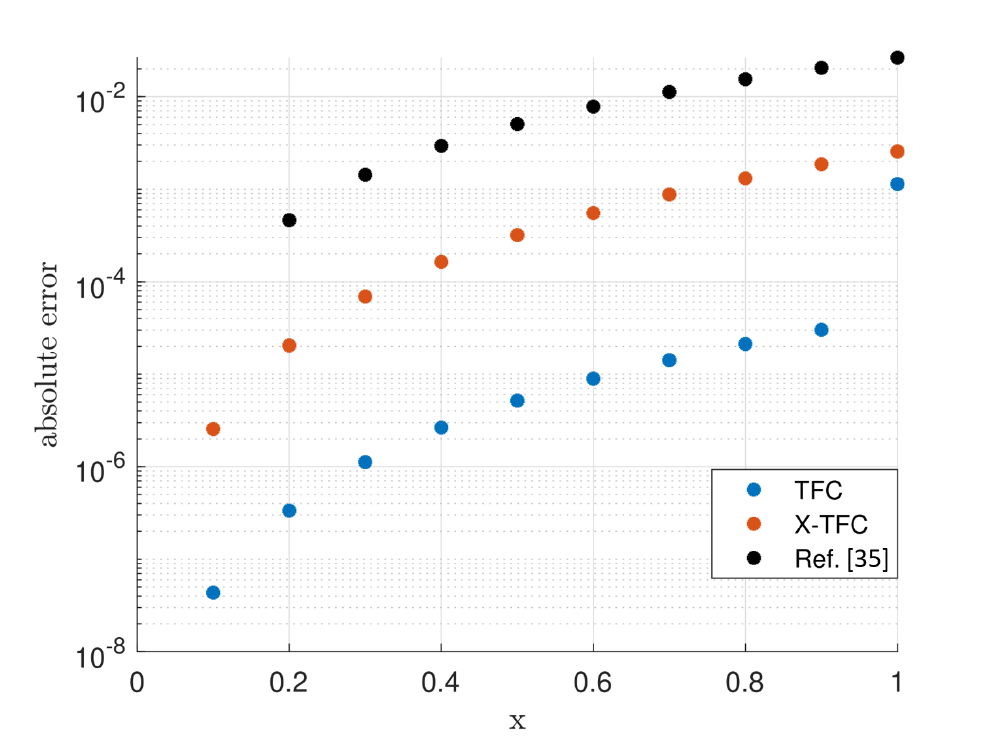
Figure 4. Absolute error on test points for problem